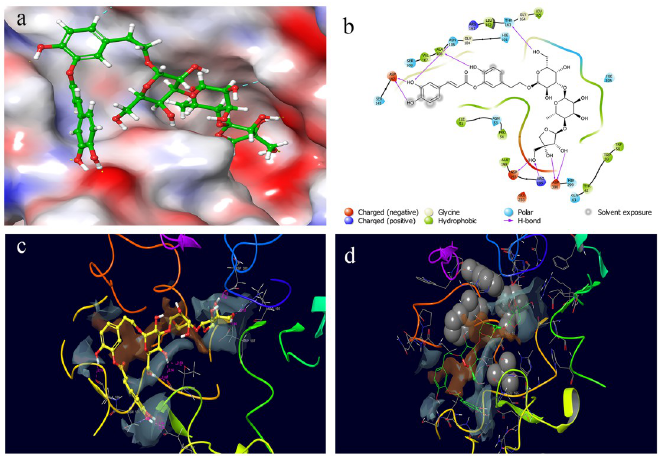
Fig 1. Docked poses and molecular interactions of newboulaside B in the binding site of HPA: (a) 3D molecular surface diagrams, and (b) 2D ligand interactions of newboulaside B with HPA. Glide XP molecular docking contributing term in the HPA and newboulaside B complex: (c) HBOND (hydrogen bond) between HPA and newboulaside B (pink interaction) and (d) PhobEn (hydrophobic enclosure reward) of HPA (CPK gray), and PhobEn of newboulaside B (green ball and stick). The hydrophobic/hydrophilic map is represented as gray/brown patches.